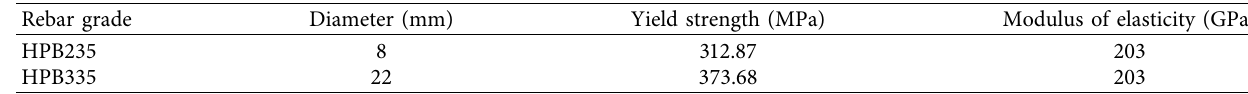
Table 1: Mechanical performance index of the steel bar.